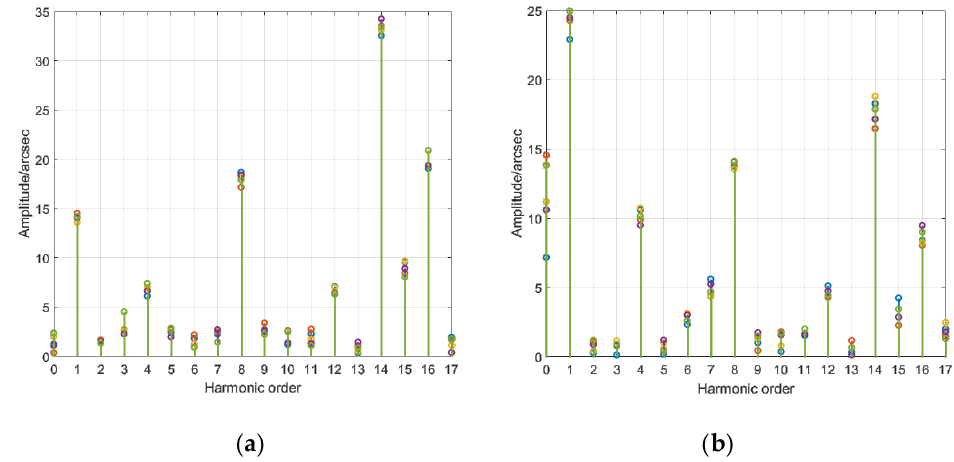
Figure 6. Harmonic amplitude-order diagram of joint module angle errors: ( a ) joint module a; ( b ) joint module b.